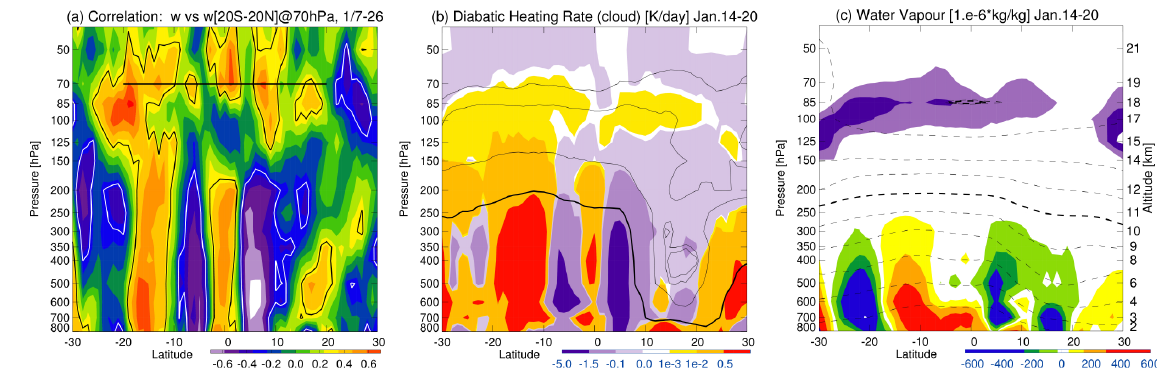
Figure 3. (a) Latitude–pressure sections of correlation between the vertical wind averaged over 20 ◦ S–20 ◦ N at 70hPa (thick line) and vertical wind at each level and latitude for the period of 7–26 January. Latitude–pressure sections of (b) latent heating rate due to cloud formation (Kday − 1 ) (contours) and (c) the water vapour concentration (10 − 6 kgkg − 1 ) (dashed contours) averaged between 14 and 20 January. The thin contours in (b) are values of 10 − 3 × 10 i ( i = 0 , 1 , 2) (Kday − 1 ). The thick contour is 1.0 (Kday − 1 ). The dashed contours in (c) are values of 10 4 × 10 i/ 3 ( i = 0 , 1 , 2 ,..., 10) (10 − 6 kgkg − 1 ); the thick dashed contours indicate 4.6 and 100 (10 − 6 kgkg − 1 ). Anomalies with respect to the 7–13 January average are shown by colour shading. The light and heavy purple in (c) indicate values of − 0.3 (10 − 6 kgkg − 1 ) and below and − 0.6 (10 − 6 kgkg − 1 ) and below,